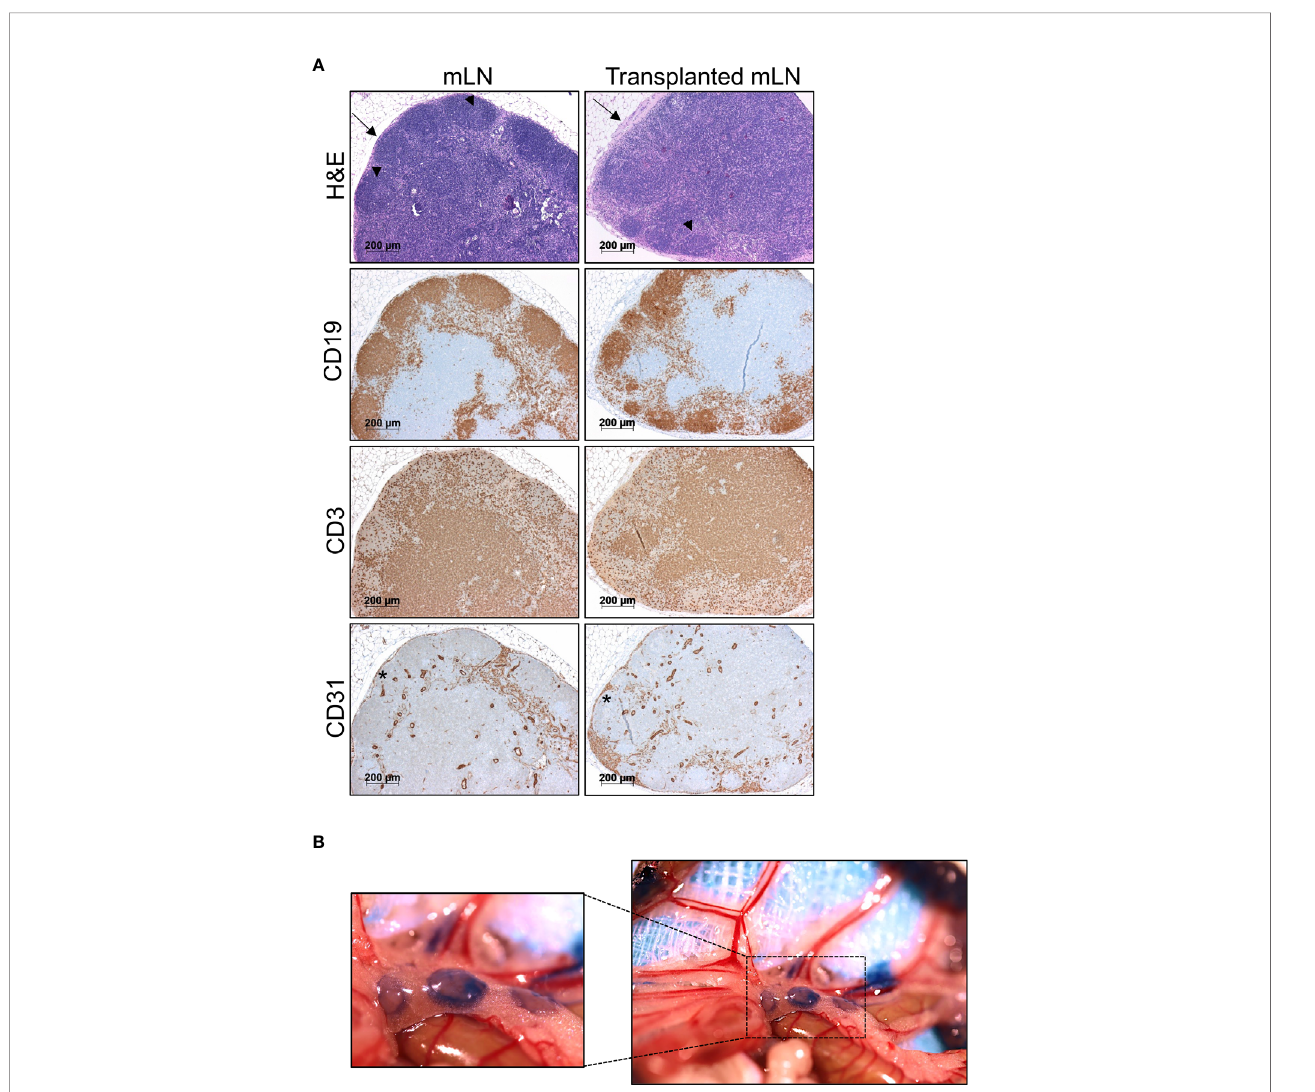
FIGURE 3 | Transplanted mLNs retain normal morphology, cell distribution and lymphatics. (A) H&E stainings of transplanted vs. non-transplanted mLNs reveal a regular immune architecture with B cell follicles and some germinal centers (arrowheads) in both settings in the cortex and T cell zones (top). Lymph node capsules (arrow) display signs of capsule fi brosis in transplanted mLNs. Immunohistochemical analysis of CD19 + B cells con fi rm proper B cell follicles in the cortex and distribution of CD3 + T cells dominating in the paracortical areas. CD31 staining on LECs in the subcapsular sinus (asterisk) revealed an intact structure of the mLN capsule, 5-6 weeks after mLN transplantation. (B) Donor mLNs lymph vessels conjoin to recipient ’ s intestinal lymphatic vasculature after transplantation. Evans blue injected into the iliac Peyer ’ s patches drains into the transplanted mLNs, 5 weeks after mLN